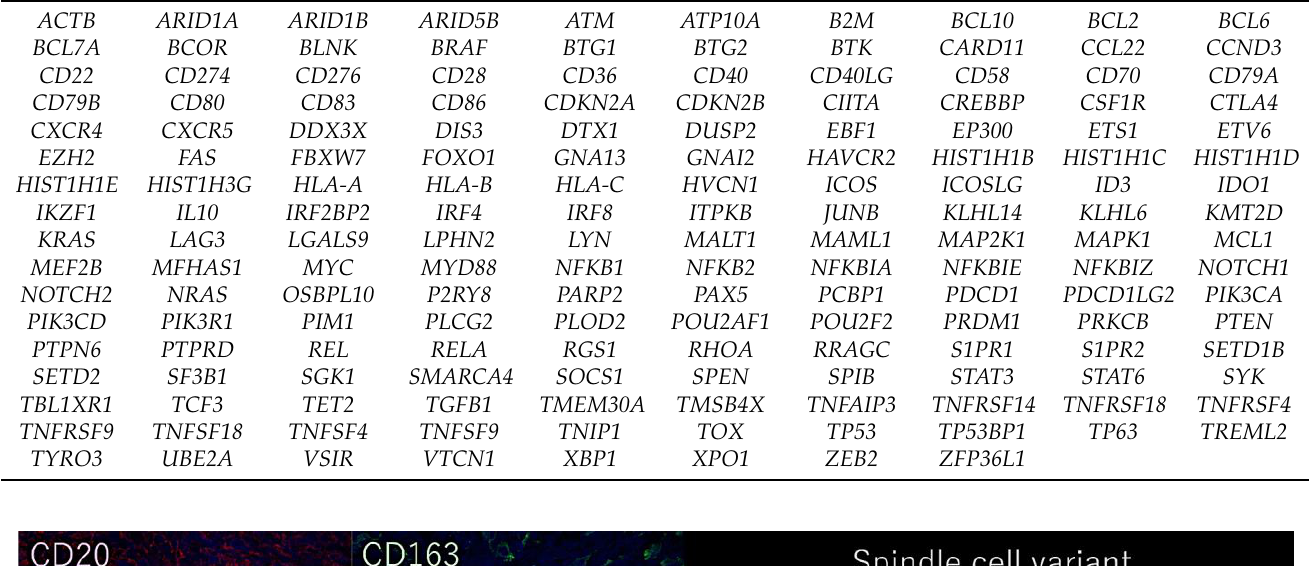
Table A1. List of genes in the custom NGS panel.